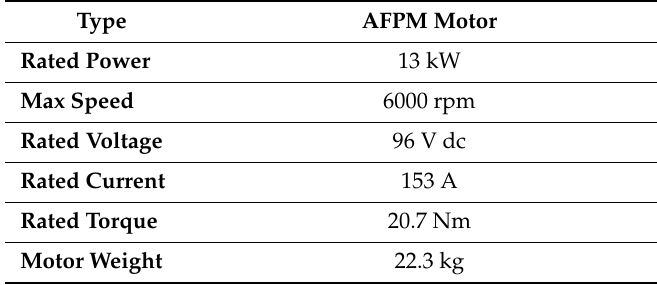
Table 1. Technical specifications of the motorbike’s motor. AFPM: axial flux permanent